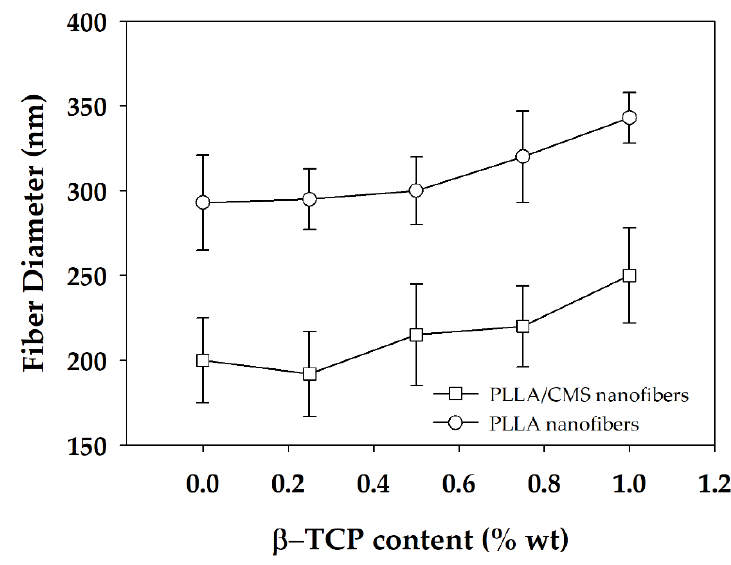
Figure 6. Average diameter of PLLA / β -TCP and PLLA / CMS / β -TCP nanofibers at the di ff erent compositions of β -TCP.